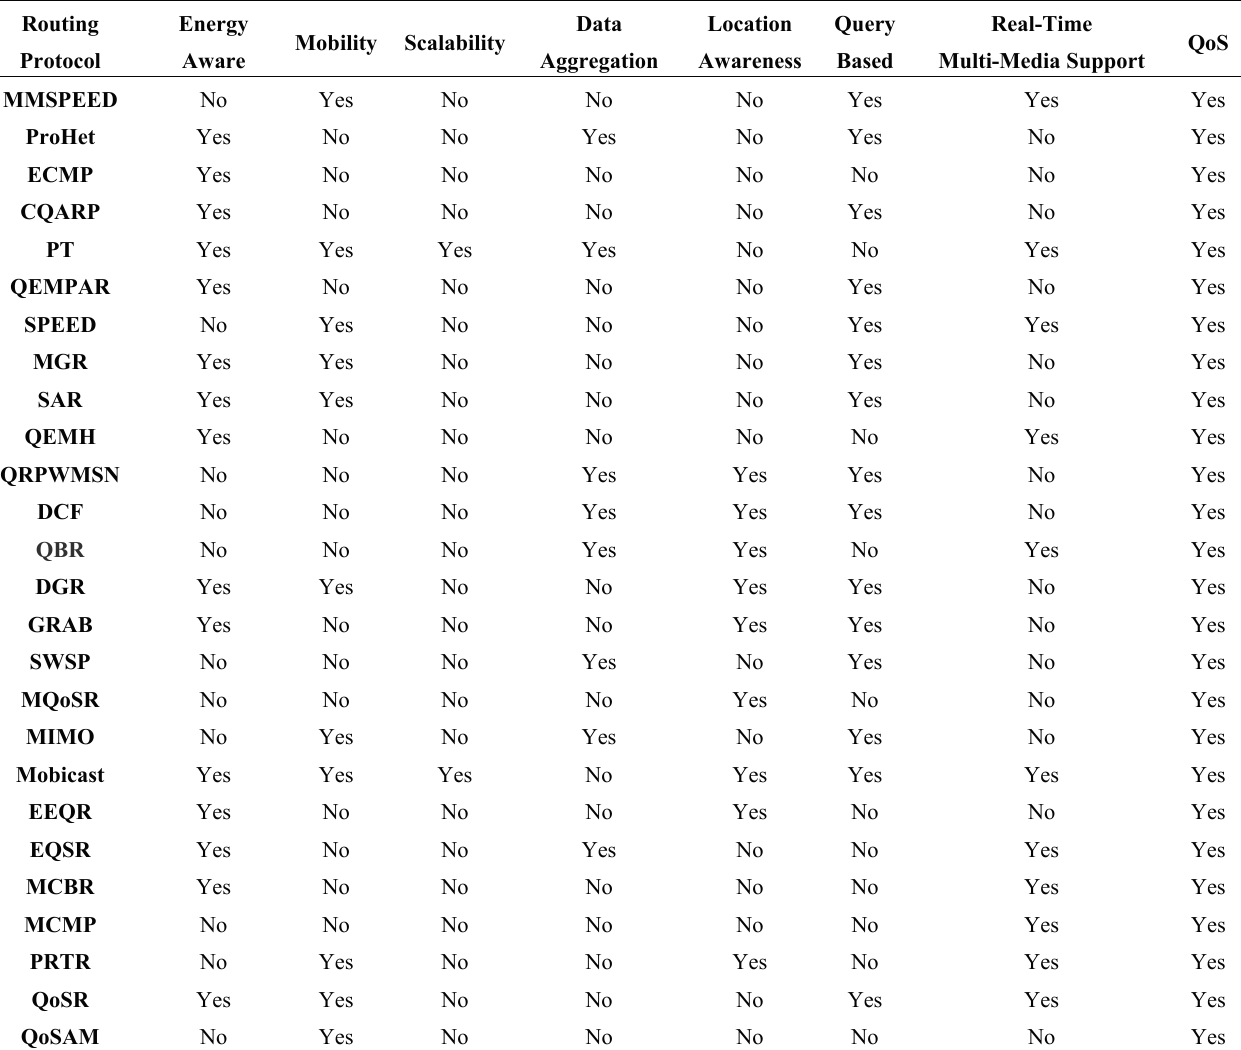
Table 2. Evaluation and comparison of QoS routing protocols over